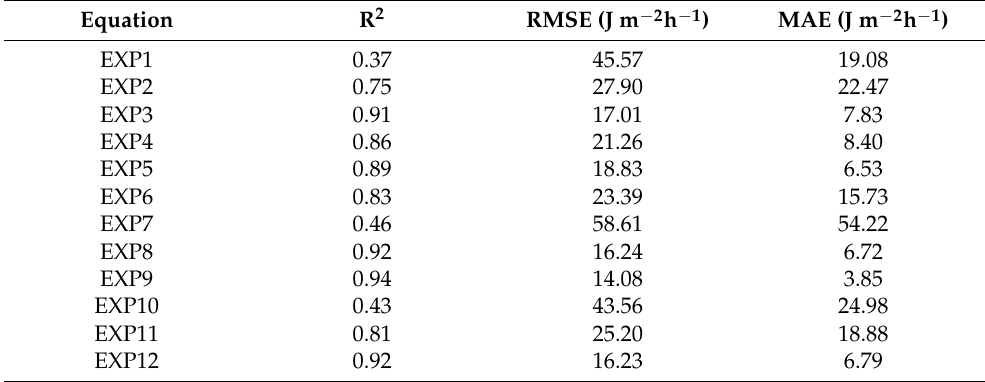
Table 4. Statistical analysis results of 12 relationships between KE exp and I r in the